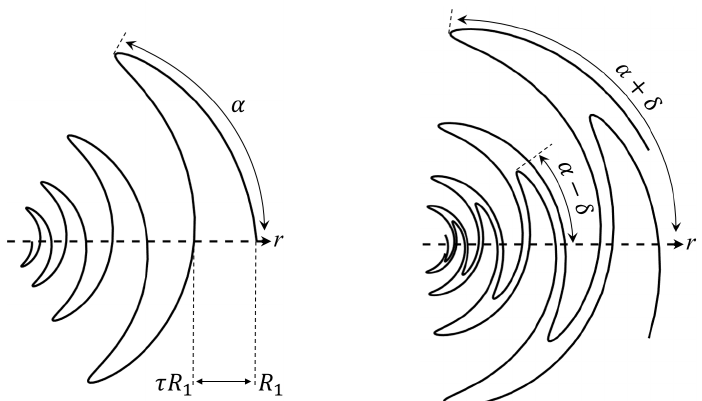
Figure 3. Illustration of sinuous antenna design parameters: angular width α , expansion ratio τ , outermost cell radius R 1 , and curve rotation angle δ